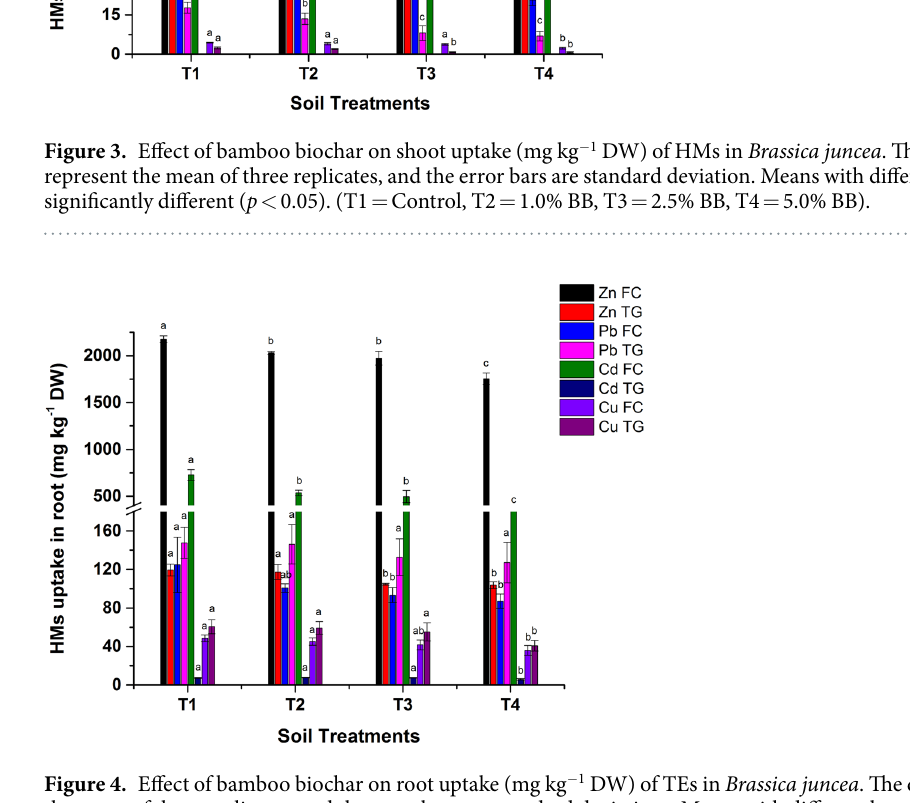
Figure 4. Effect of bamboo biochar on root uptake (mg kg − 1 DW) of TEs in Brassica juncea . The data represent the mean of three replicates, and the error bars are standard deviations. Means with different letters are significantly different ( p < 0.05). (T1 = Control, T2 = 1.0% BB, T3 = 2.5% BB, T4 = 5.0%